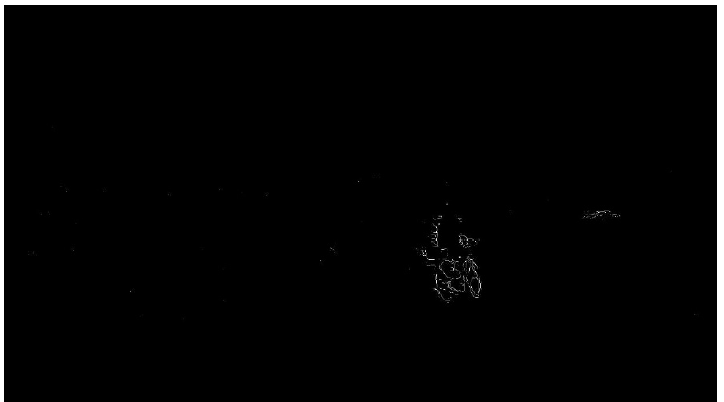
Figure 10. Difference in Sobel edge accumulation due to